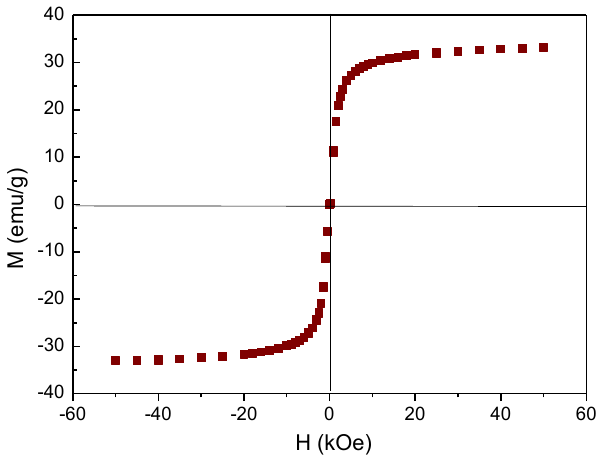
Figure 7. Magnetization curve of MagP ® – OH magnetic nanoparticles.